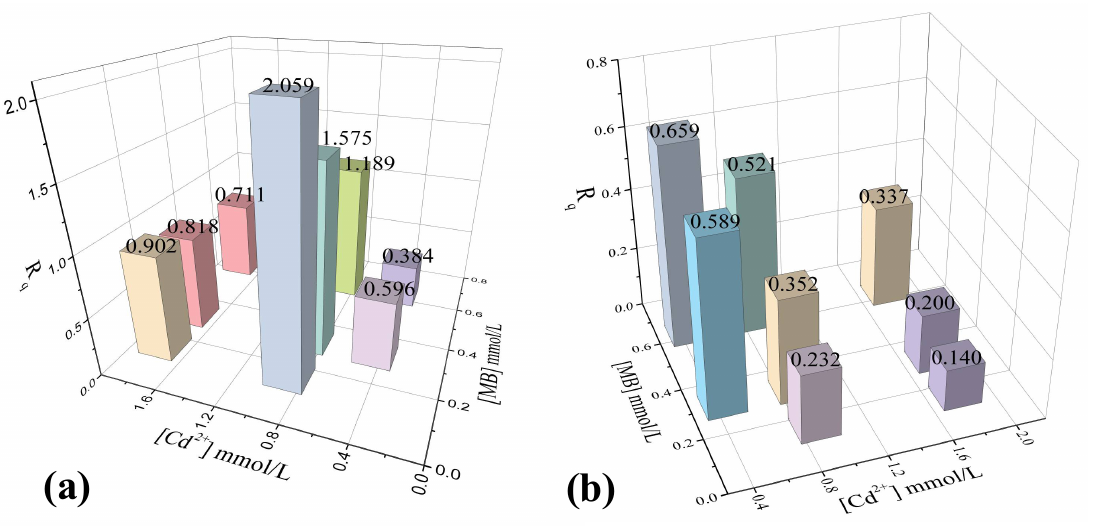
Figure 5. Relationship of the adsorption capacity (Rq) at initial concentrations of both contaminants. ( a ) Rq for Cd 2+ in the presence of MB. ( b ) Rq for MB in the presence of Cd 2+ . At medium equilibrium concentrations of Cd 2+ (0.80–0.92 mmol L − 1 ), the Cd 2+